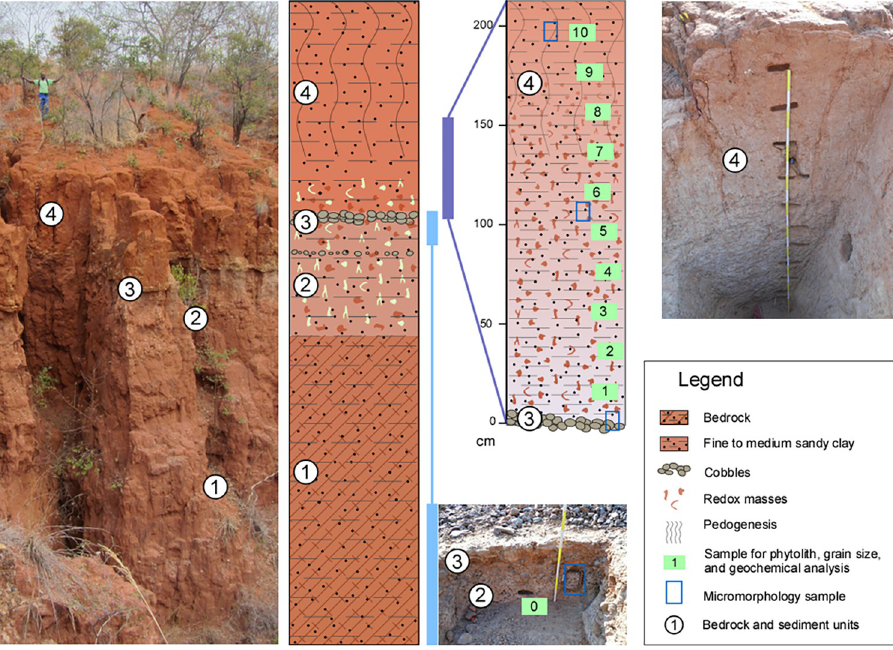
Fig 7. Sediment column at SW23. Exposure between SW23A and B showing location of samples collected for sedimentological and environmental